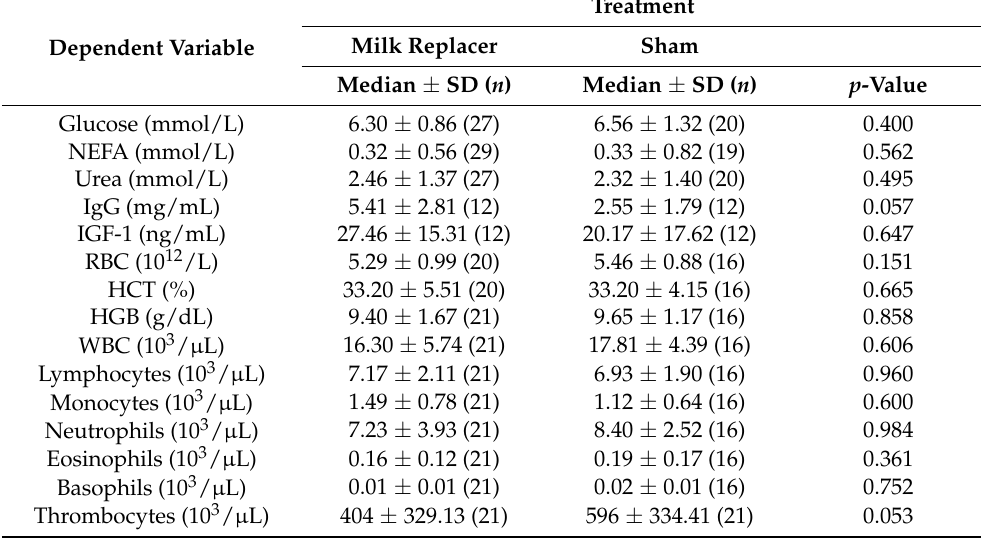
Table 2. Blood values (median ± SD) of glucose, non-esterified fatty acids (NEFA), urea, immunoglob- ulin G (IgG), insulin-like growth factor 1 (IGF-1), red blood cells (RBC), hematocrit (HCT), hemoglob- ulin (HGB), white blood cells (WBCs), lymphocytes, monocytes, neutrophils, eosinophils, basophils and thrombocytes of low-birth-weight piglets that were supplemented with a milk replacer or sham drenched (linear mixed models, p ≤